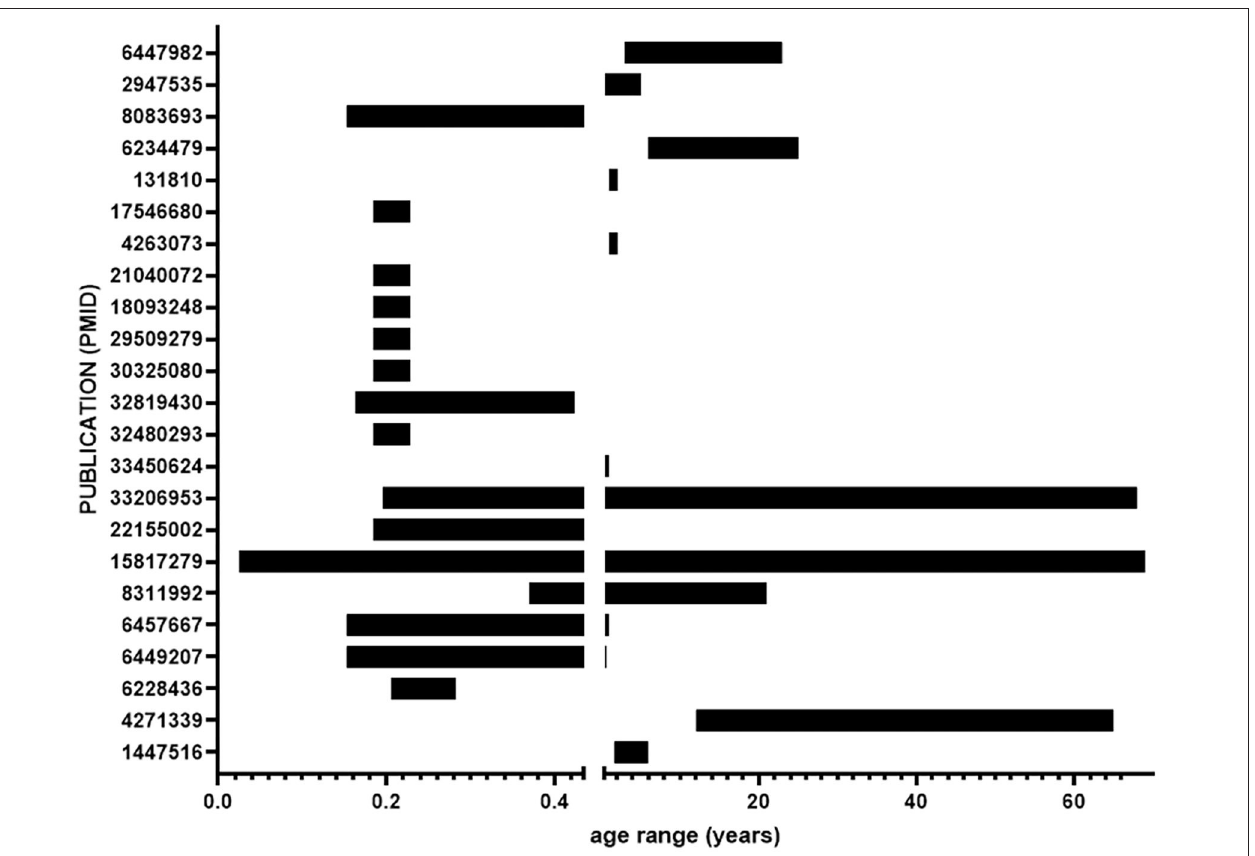
FIGURE 4 | Age ranges of samples from included studies. Ages range from 16 days gestation to 69 years. The break in the x -axis indicates